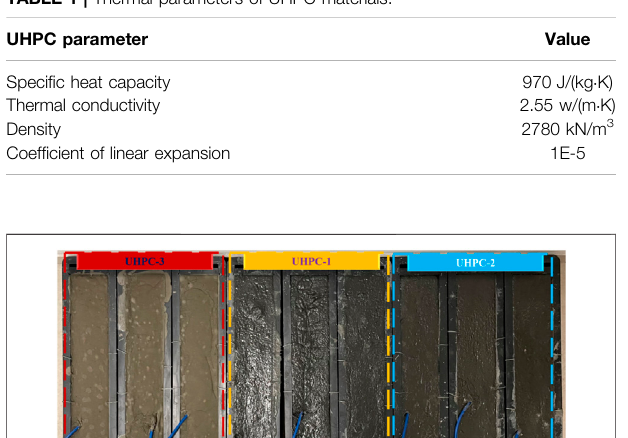
FIGURE 4 | Constrained shrinkage